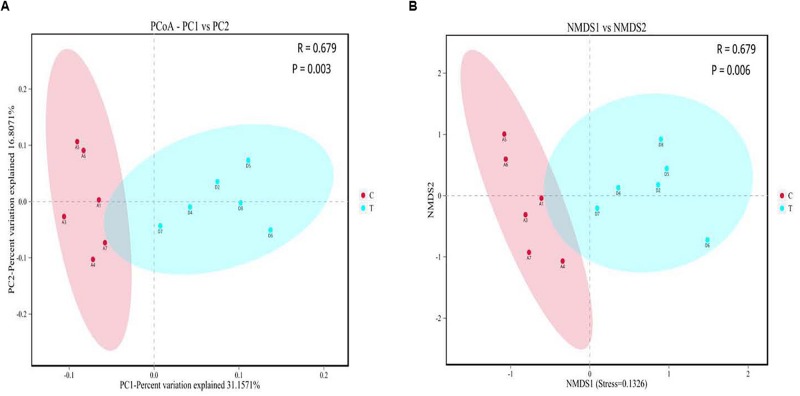
Beta diversity analysis of gut microbiota between the control and Clostridium butyricum treatment groups. (A) Principal co-ordinates analysis (PCoA) plot; (B) Non-metric multidimensional scaling (NMDS) plot. C, control group; T, C. butyricum treatment group.